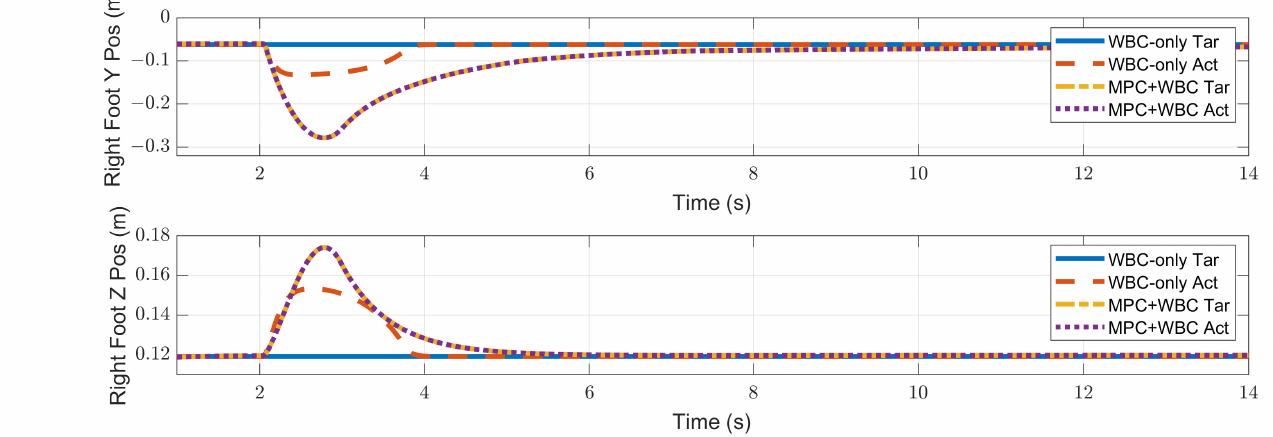
Figure 13. CoM position of the robot under the side impact of a 3.2 kg rigid ball.